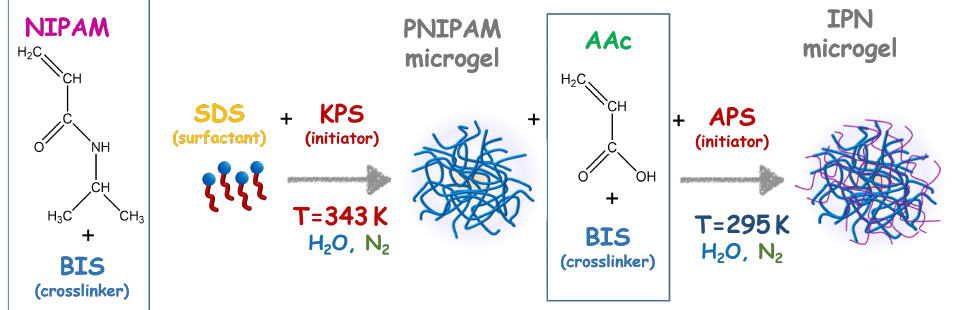
Figure 1. Schematic representation of the synthesis process that involves N -isopropylacrylamide (NI- PAM) and acrylic acid (AAc) monomers, the crosslinker N,N (cid:48) -methylene-bis-acrylamide (BIS) and the reagents: sodium dodecyl sulphate (SDS), potassium persulfate (KPS), ammonium persulfate